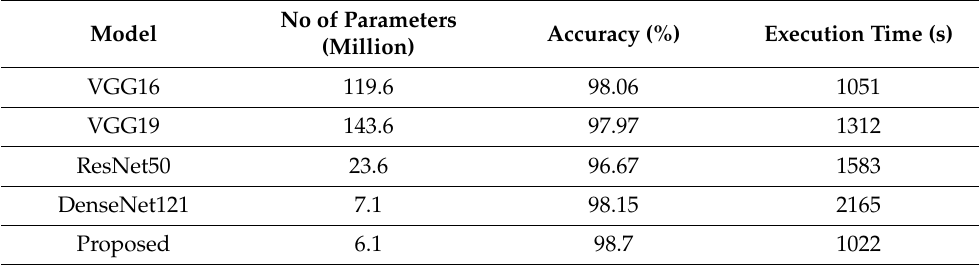
Table 3. Comparison with base